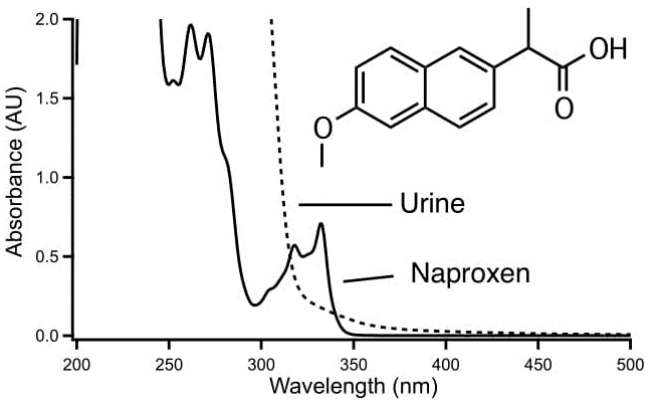
Figure 2. Absorbance spectra of naproxen (10 mg/100 mL methanol) and urine (diluted 1:3 ( v / v ) with methanol and then centrifuged).